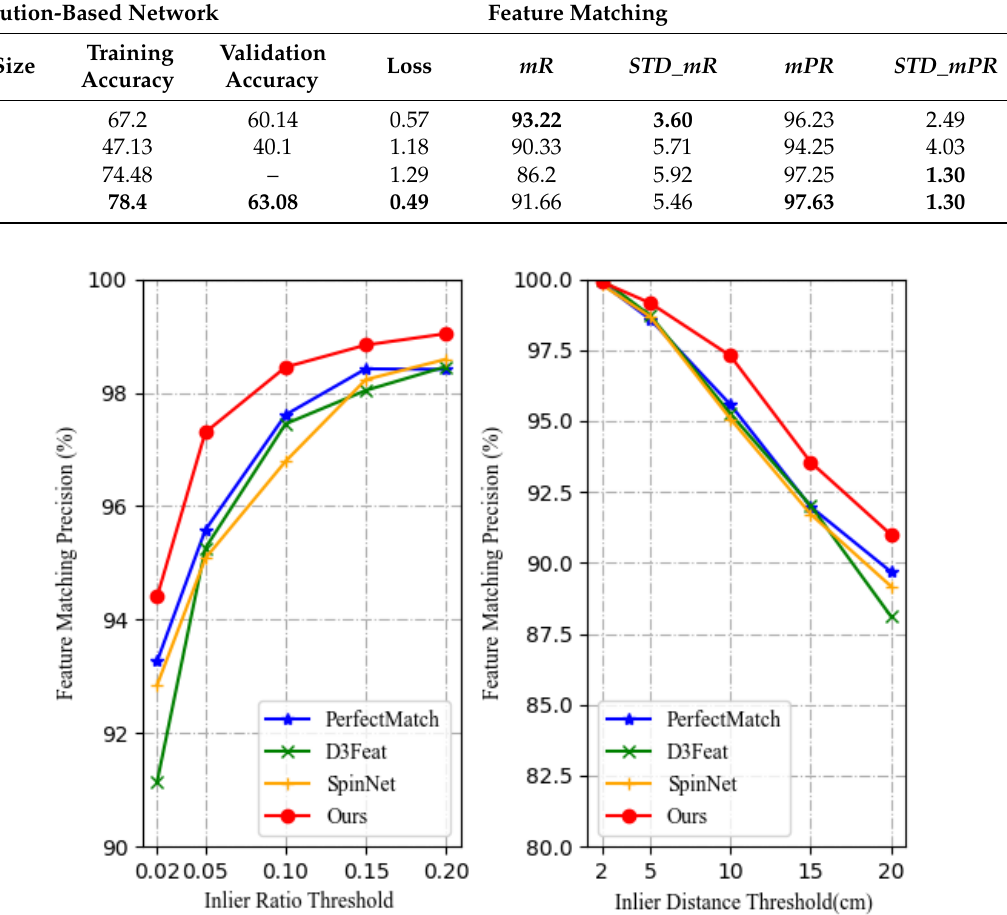
Table 3. Quantitative comparisons with the state-of-the-arts, training on BundleFusion and feature matching on 3DMatch test set. All results are reproduced on the same platform by ourselves. The best performance is shown in bold, and “–” denotes the value is unavailable.